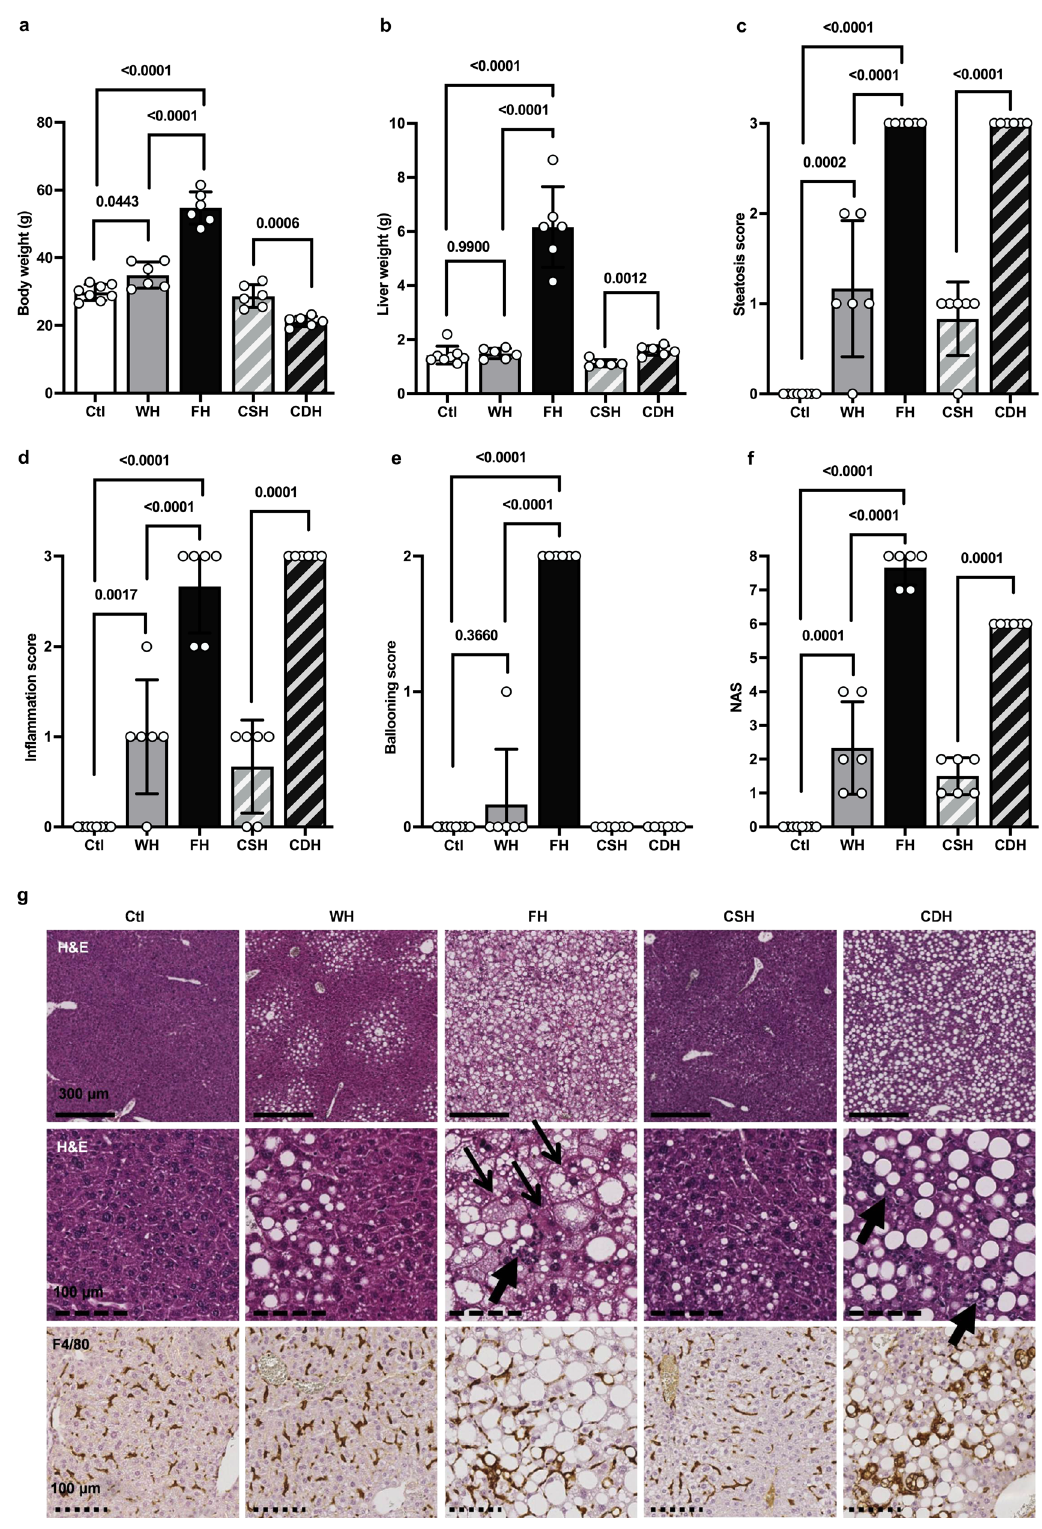
Fig. 3 | Characteristics of the NAFLD models. a Body weight, b liver weight, and histological c steatosis score, d in fl ammatory score, e ballooning score, and f total NASscorein WT mice feda normal diet (Ctl, n =8) or a high fatdiet (WH, n =6),in FOZ mice fed a high fat diet (FH, n =6) and in C57BL6/J mice fed a fat-rich choline supplemented (CSH, n =6) or de fi cient (CDH, n =6) diet (one-way ANOVA and